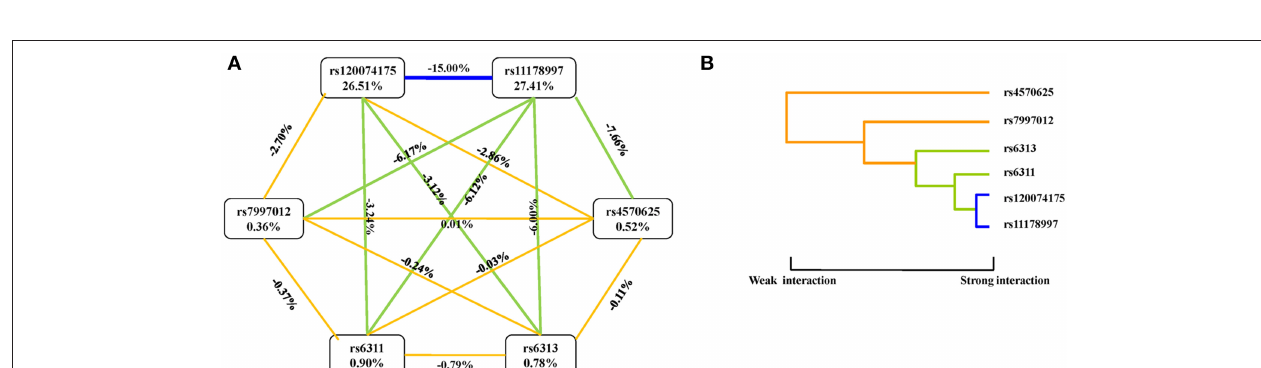
FIGURE 1 | Interaction graphs and dendrograms. (A) Interaction graphs. The percentage at the bottom of each SNP represents its interaction entropy, and the percentage on the line represents the percentage of interaction entropy between two SNPs. The golden line indicates additivity, while the blue or green lines indicate redundancy interaction. (B) Interaction dendrograms. The golden line represents additivity, while the blue line represents redundancy interaction. The shorter the dendrograms arm, the stronger the interaction.